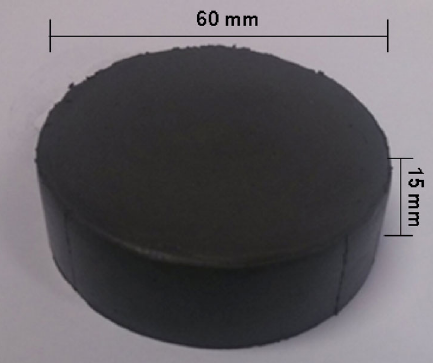
Fig. 1 Dimensions of MRE.